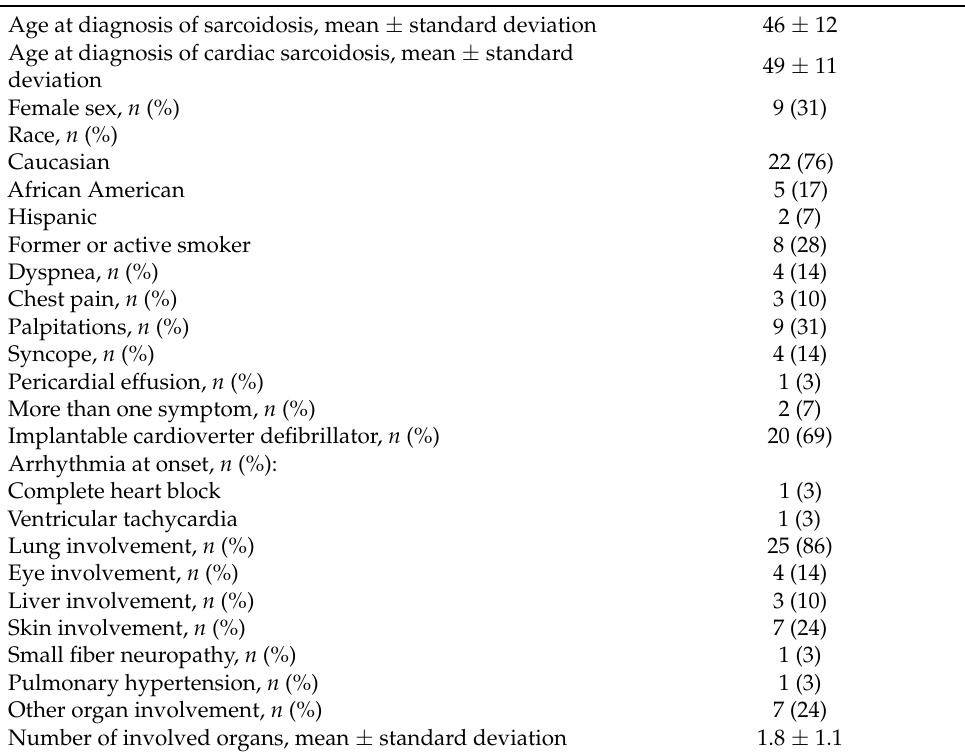
Table 1. Clinical features of cardiac sarcoidosis patients ( n = 29).